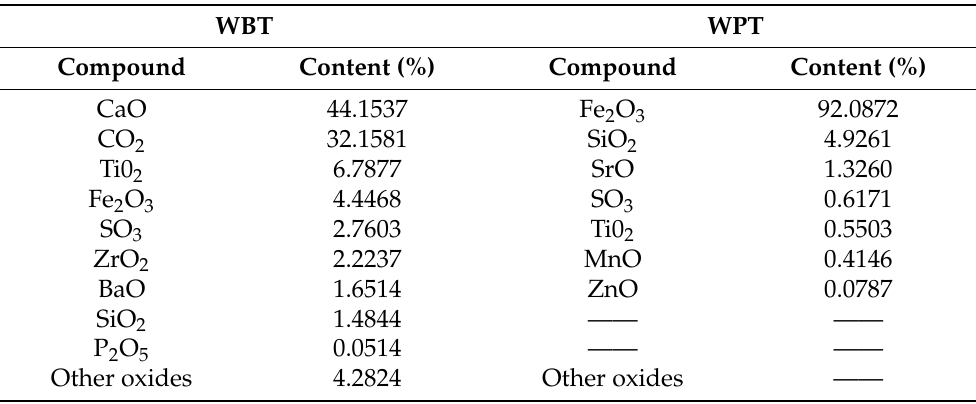
Table 2. Components of waste